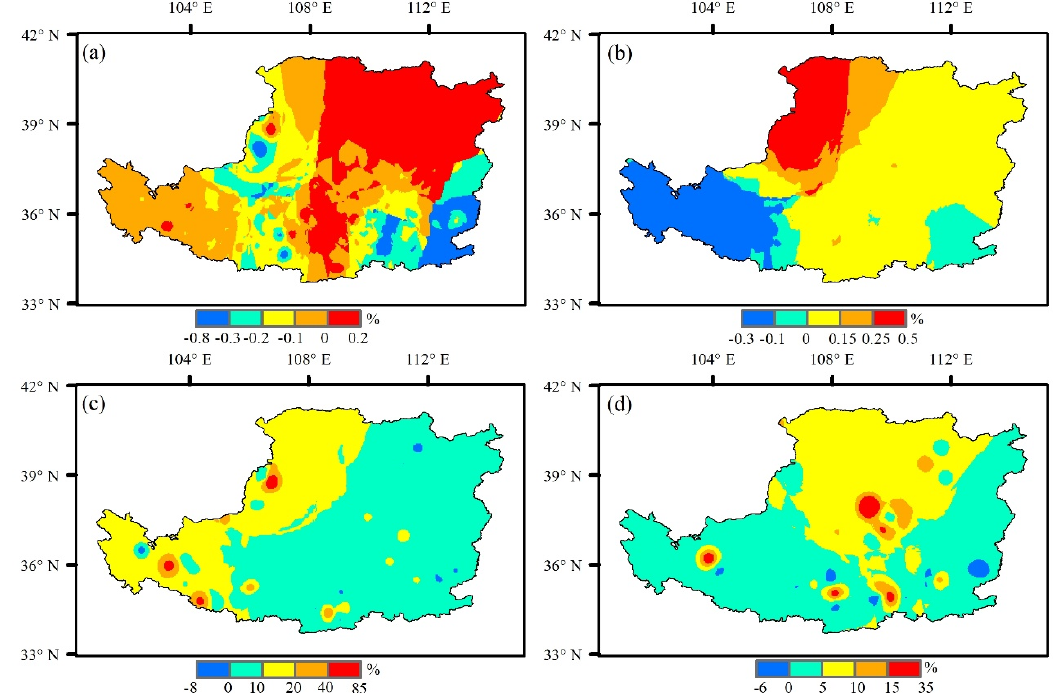
Figure 9. Incremental contribution distribution of different rainfall grades in the number and duration of rainfall events to rainfall frequency (( a ). light rainfall, ( b ). moderate rainfall, ( c ). heavy rainfall and ( d ). rainstorm).